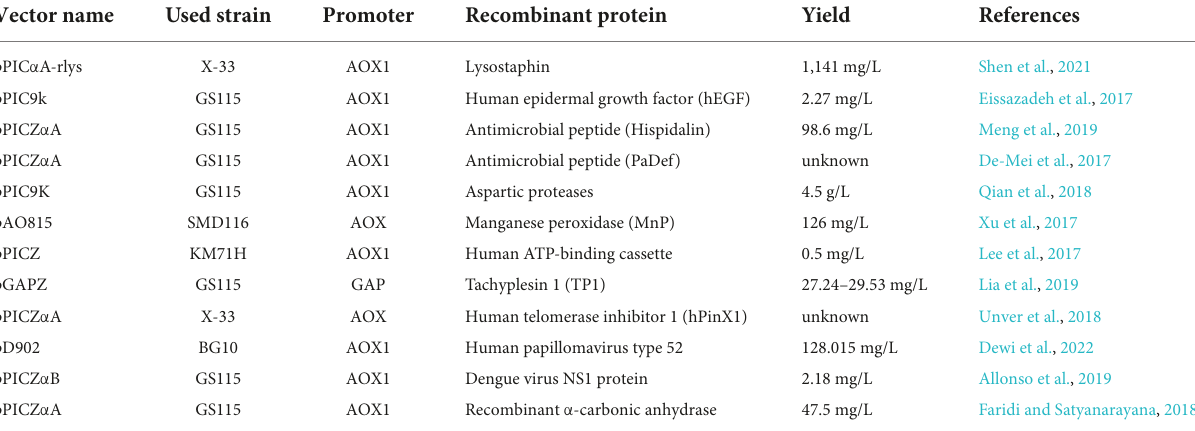
TABLE 2 The most recent recombinant protein expression systems in Pichia pastoris